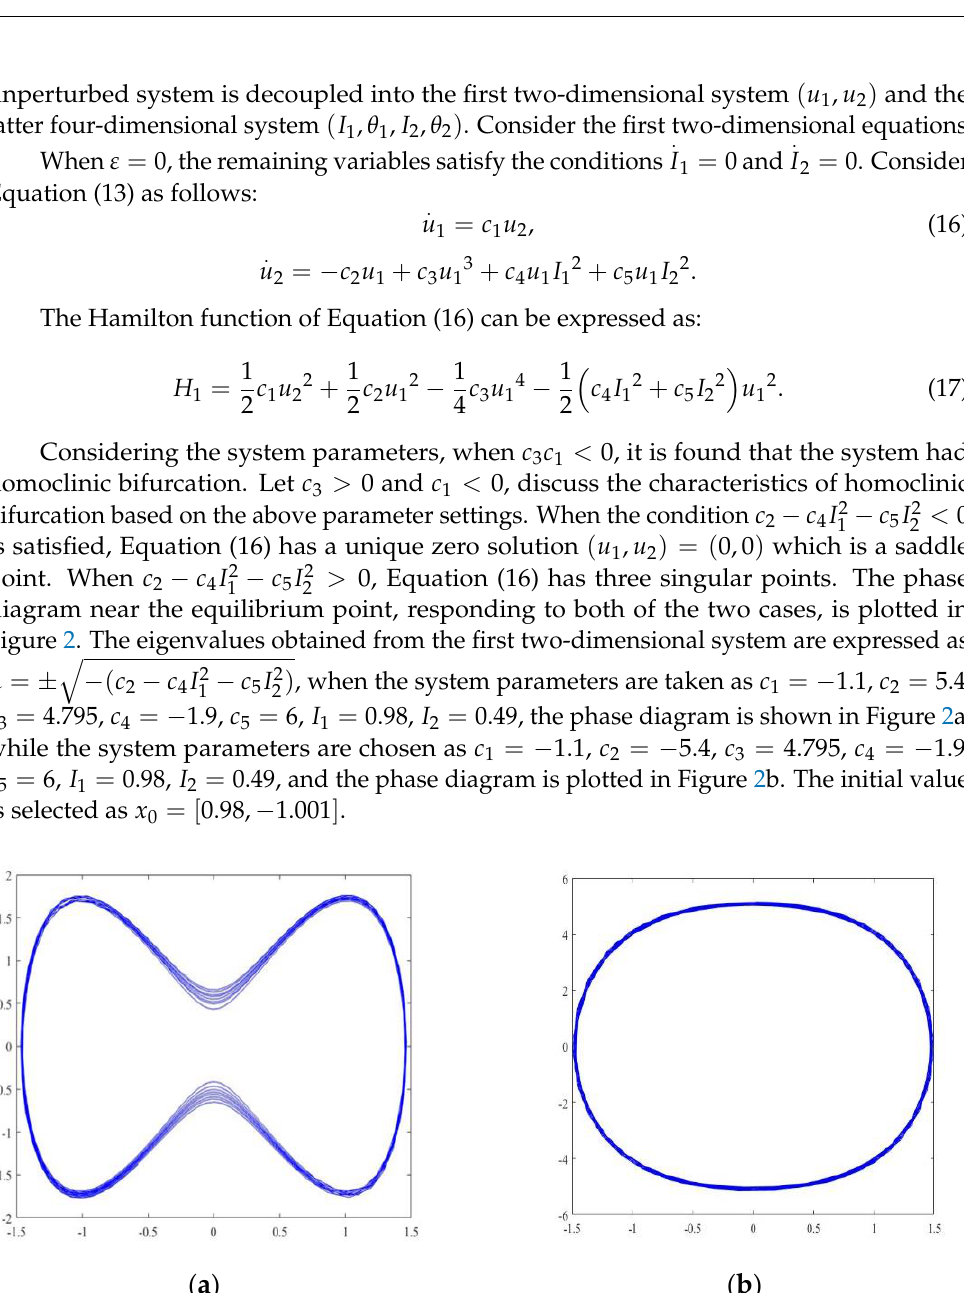
− u 2 ) under condition 1 u u − ) under 1 2